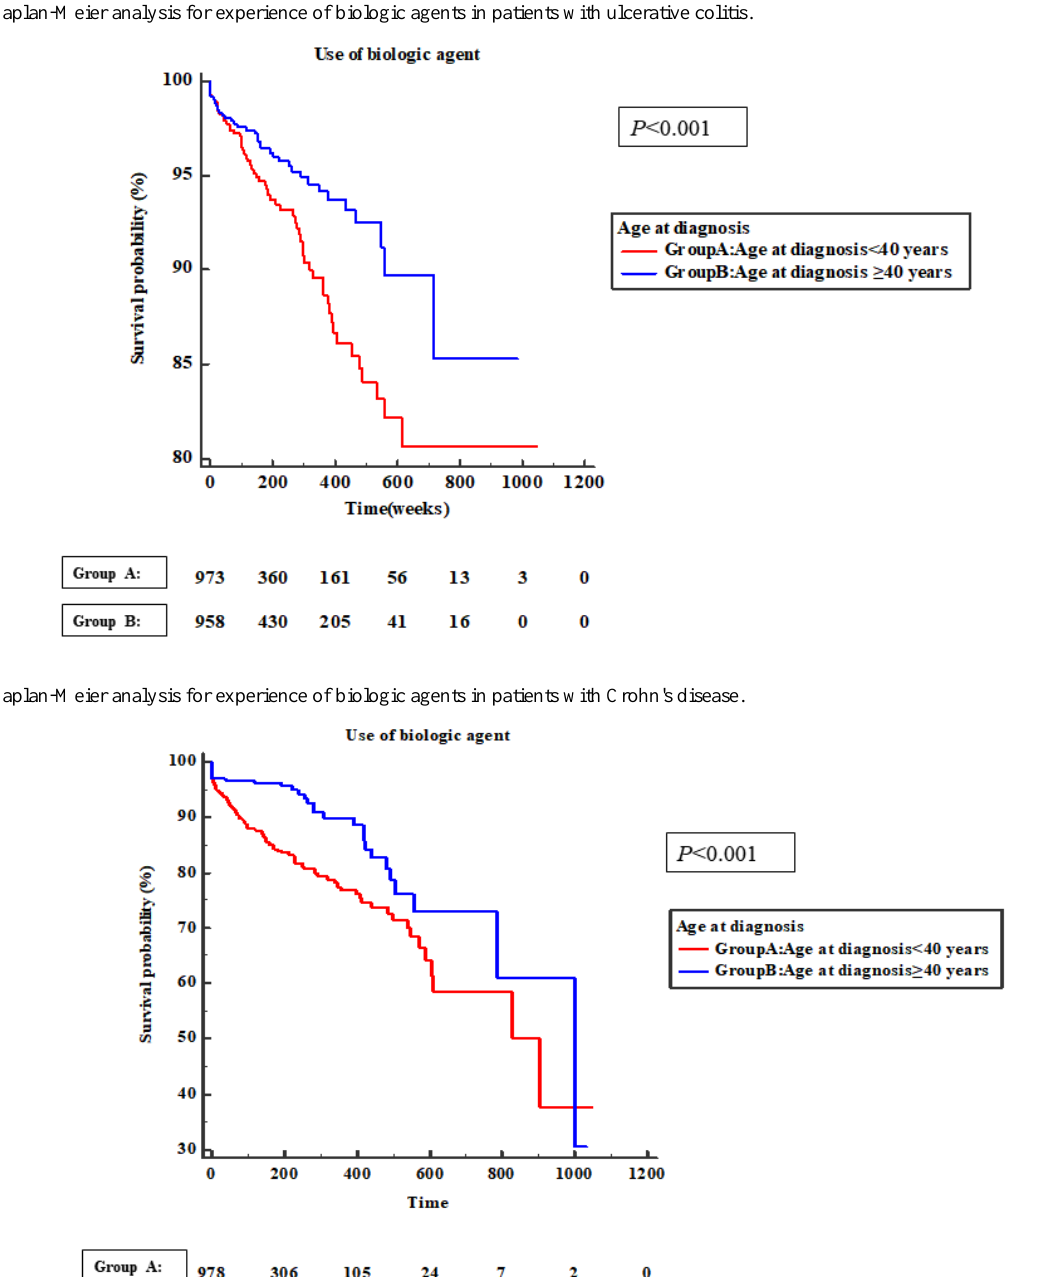
Figure 2. Kaplan-Meier analysis for experience of biologic agents in patients with ulcerative colitis.